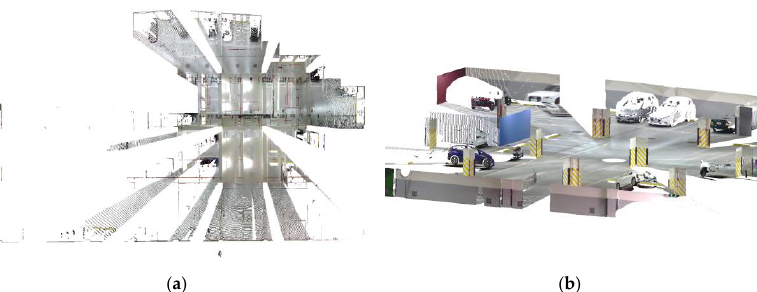
Figure 5. Top and side views of the collected points by a FARO Focus S350 in a single station. ( a ) Top view. ( b ) Side view. Seventeen plane locations, labeled A to Q, were manually extracted for calibration reference data, and the location of each plane is shown in Figure 6. The size of each plane was about 0.7 m by 1.2 m and its planar parameters were determined by the least-squares method. The parameters and fitting RMSEs are shown in Table 3. All plane fitting RMSEs were not greater than 0.001 m, indicating that the point cloud data of the FARO Focus S350 was of a certain accuracy and reliability as the calibration planes and the check planes.